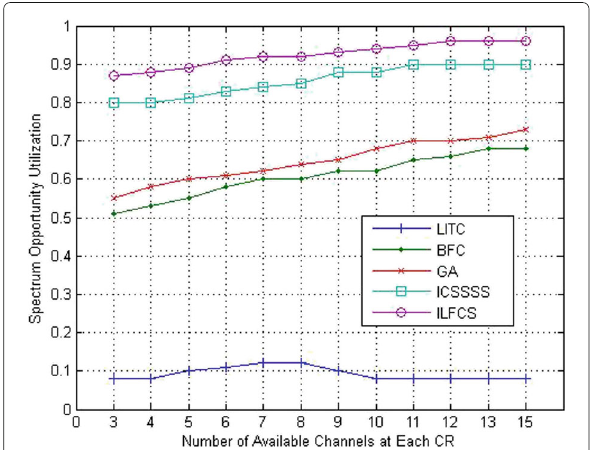
71.3%, 60.8%, and 50.8% compared to LITC, BFC, GA, and ICSSSS respectively.